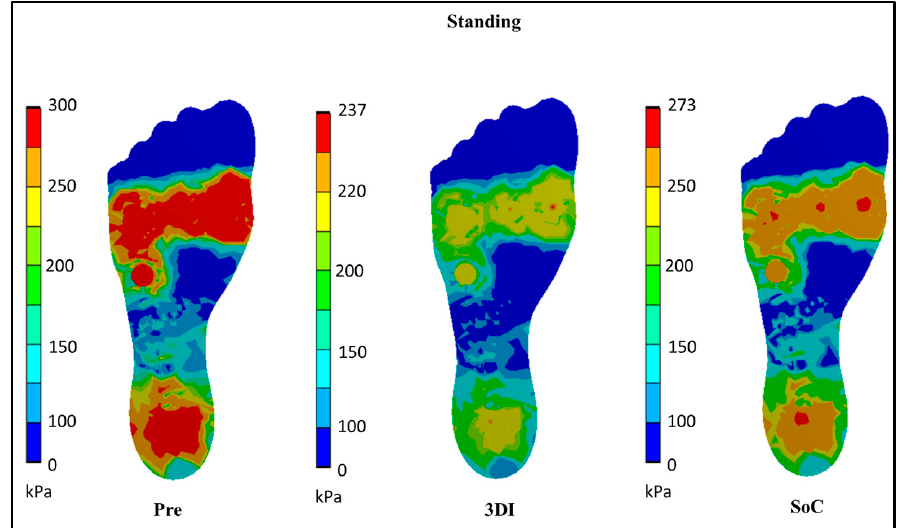
Figure 8 . Standing plantar pressure distributions across the experimental (3DI) and control (SoC) groups .